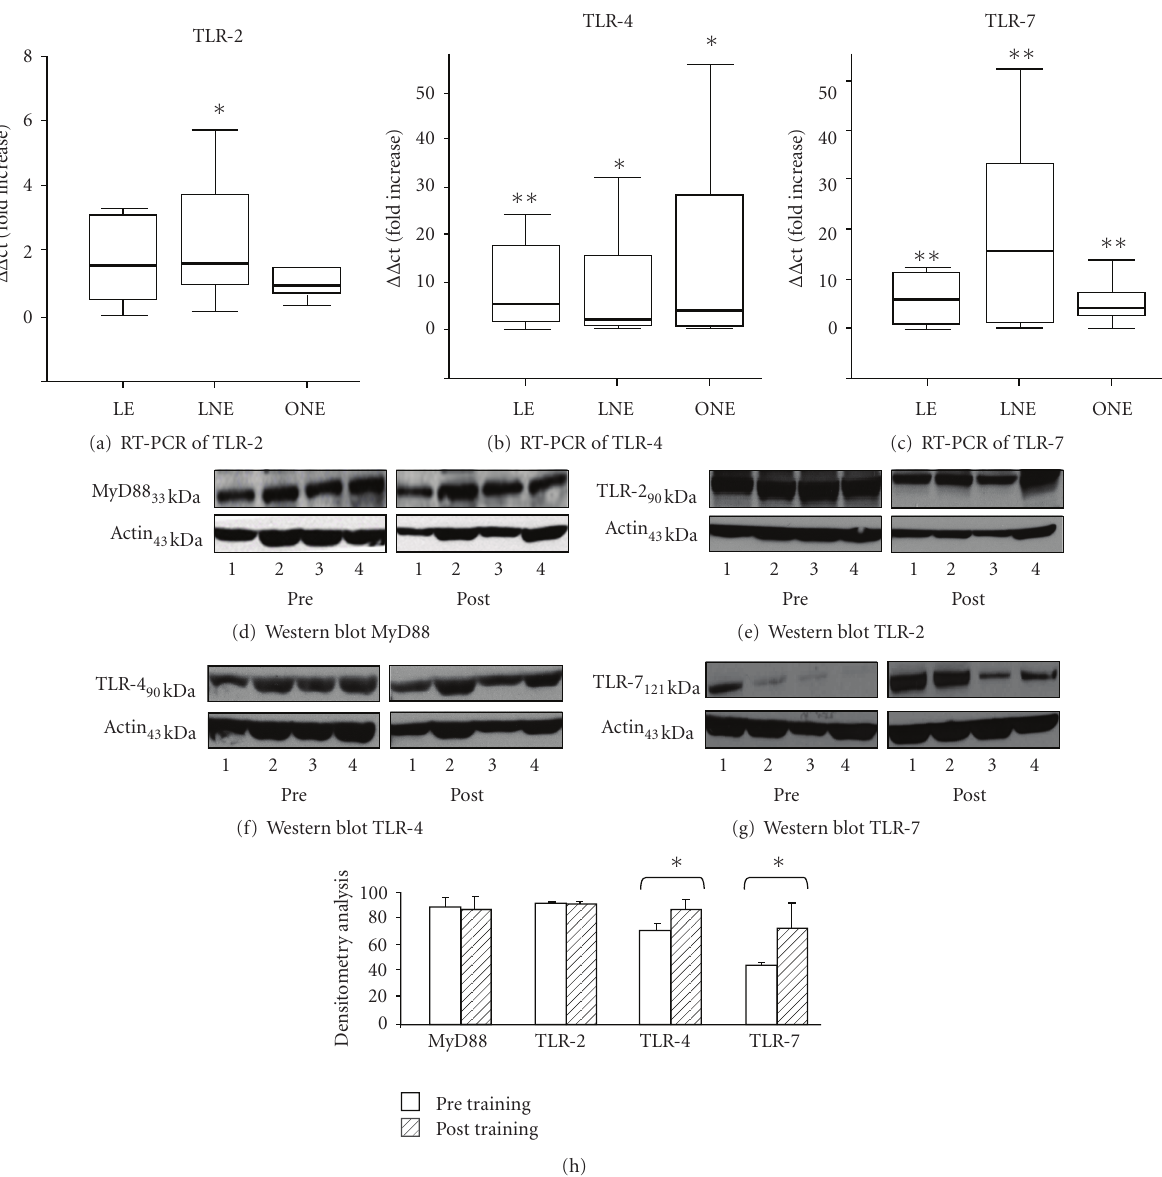
Figure 2: Expression of TLR-2 (a), TLR-4 (b), and TLR-7 (c) by analysis of mRNA levels via RT-PCR. Training-induced changes were analyzed using the delta-delta ct method. Expression of MyD88 (d), TLR-2 (e), TLR-4 (f), and TLR-7 (g) by analyses of protein expression (Western blot of 4 representative examples of the LNE-group). Densitometry analysis (h) found a significant increased expression for TLR-4 and TLR-7. For MyD88 and TLR-2, no significant changes were found. Statistical analysis of the di ff erent time-points (intra group-analysis) was performed using the Wilcoxon-Test; the comparison of the di ff erent groups with each other (inter group analysis) was done by using the Mann-Whitney U Test ( ∗∗ P < . 01; ∗ P < . 05; n = 15 / 16 / 16 for PCR and n = 8 for Western